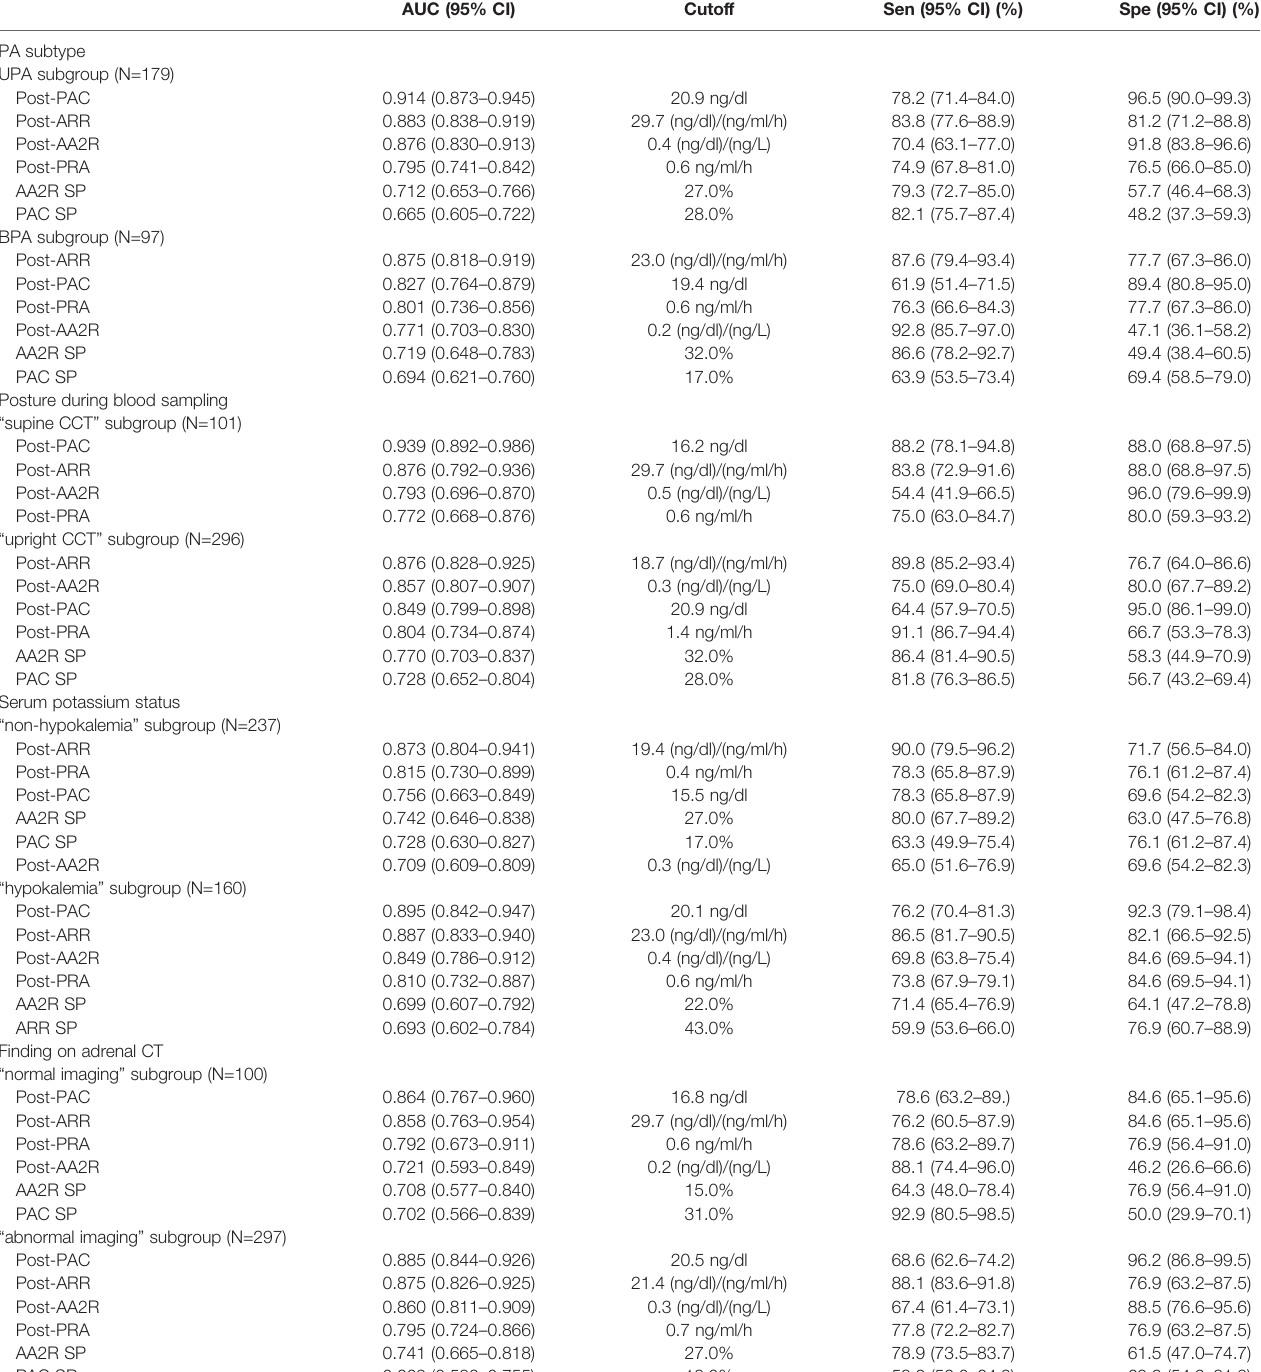
TABLE 4 | Subgroup analyses on the value of CCT-associated single indexes for distinguishing between PA and EH. AUC (95%